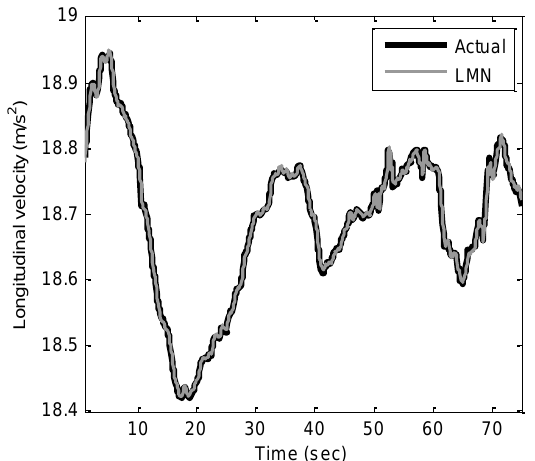
Figure 6. Estimated longitudinal velocity.